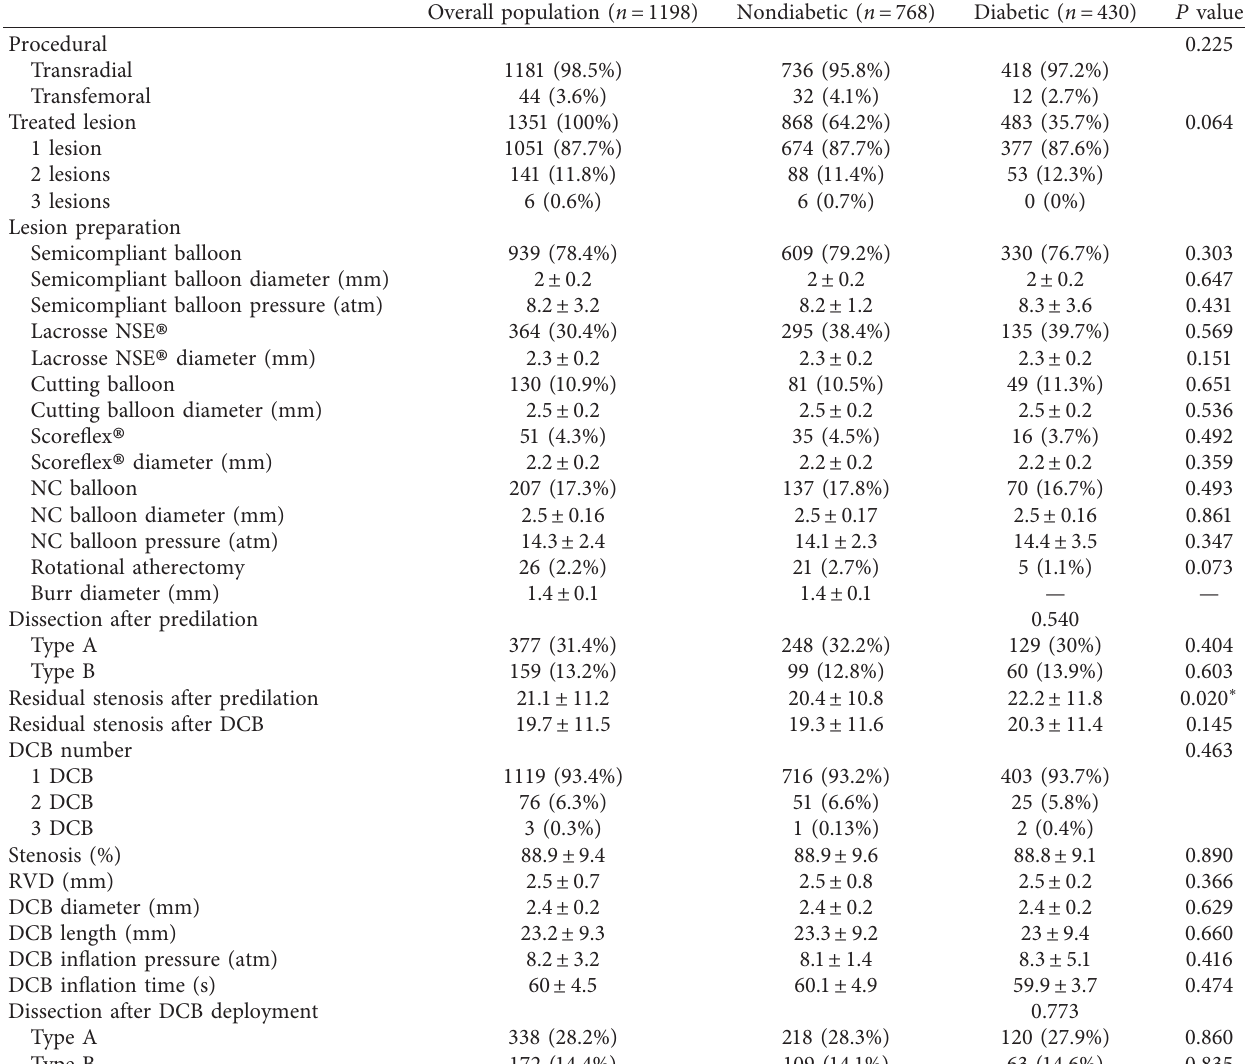
Table 3: Procedural